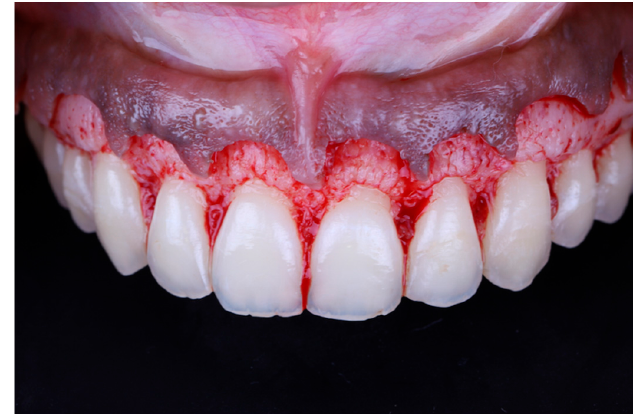
Figure 6. Tooth length after gingival excision.